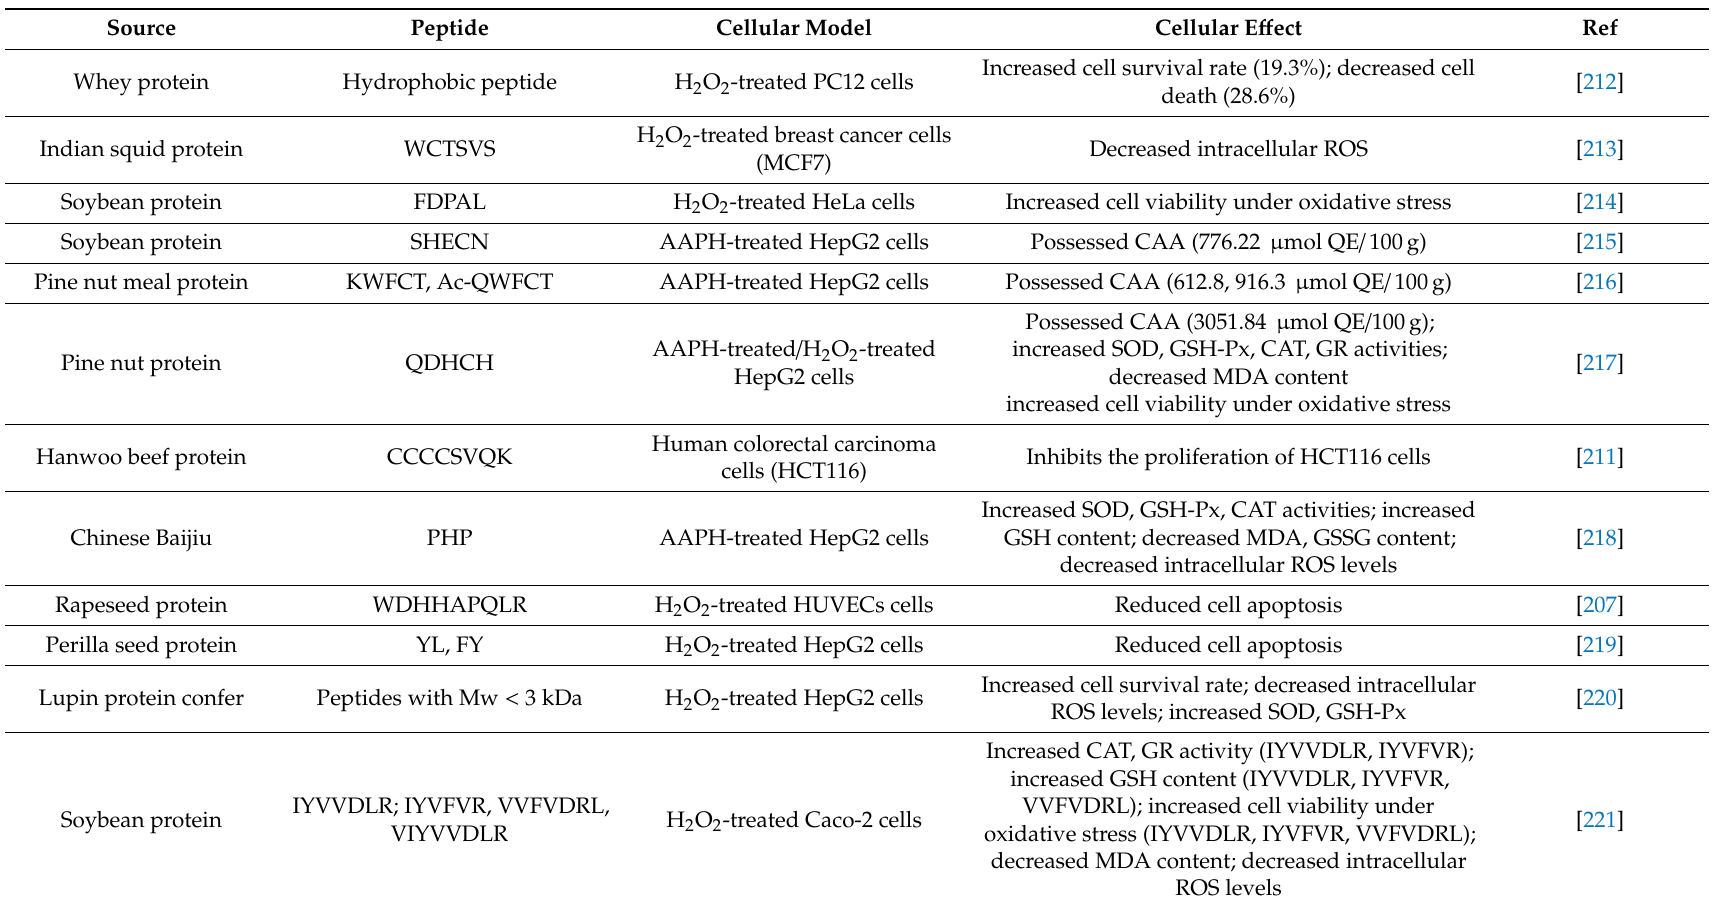
Table 3. Evaluation of in vitro cell model of peptidic antioxidants 1